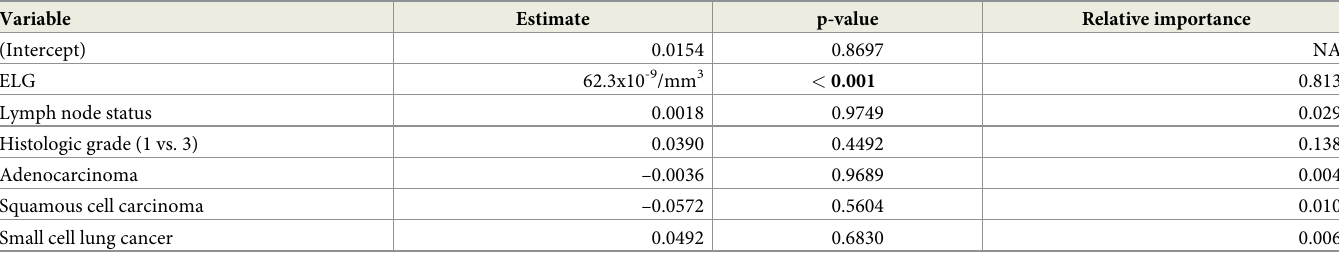
Table 2. Analytical model for lung